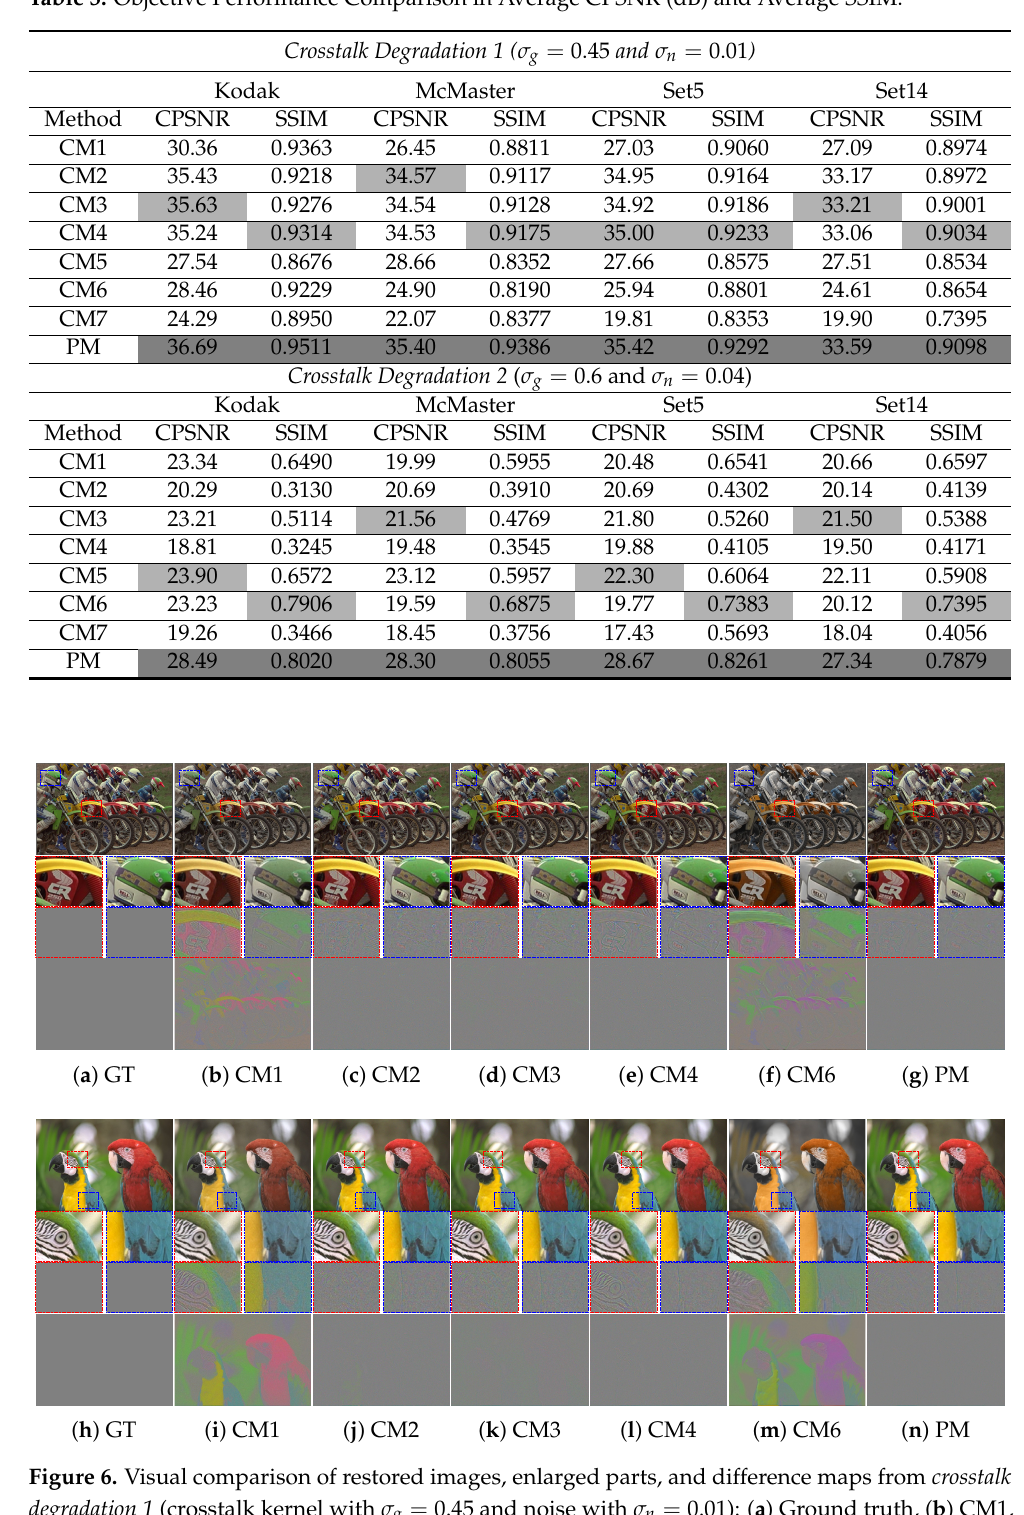
Table 3. Objective Performance Comparison in Average CPSNR (dB) and Average SSIM.